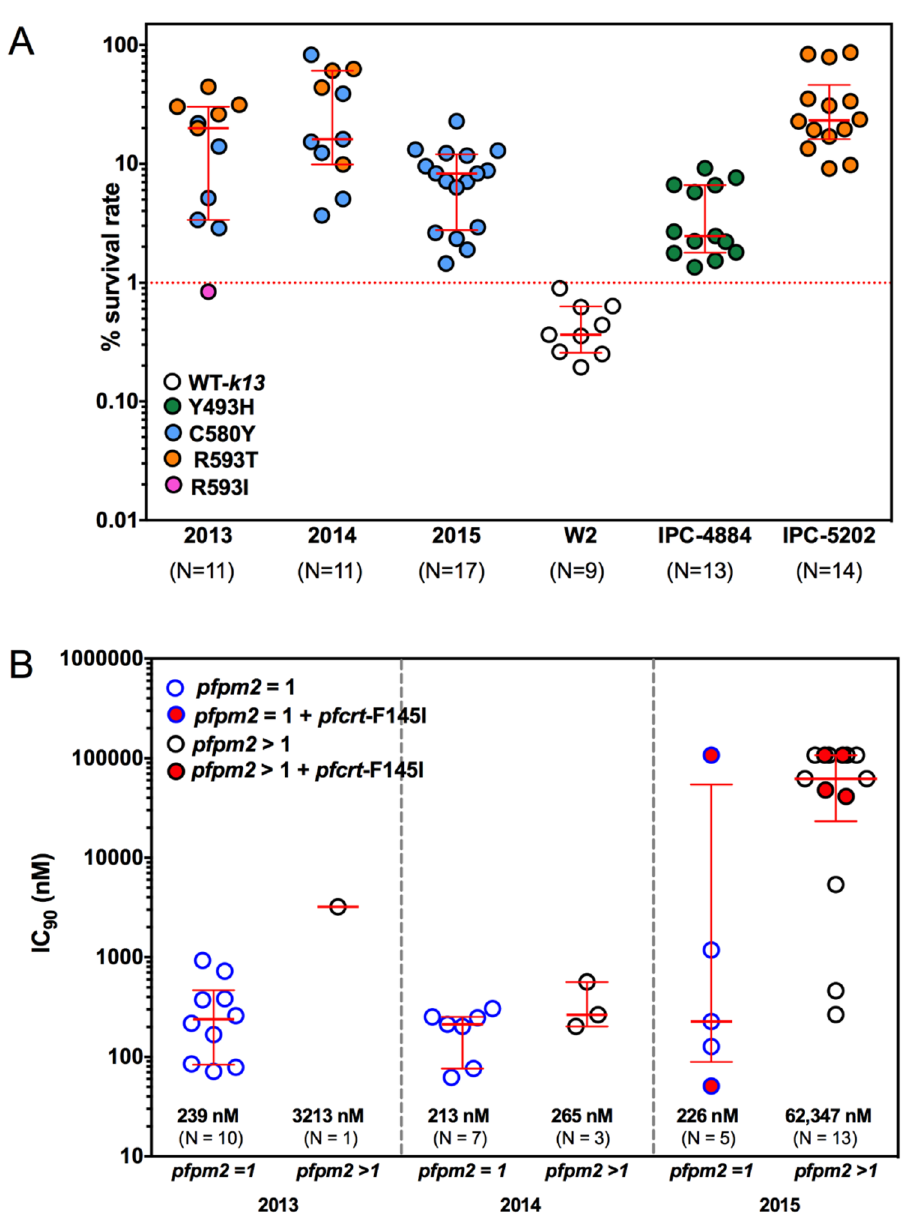
Figure 2. In vitro characterization. ( A ) RSA and pfk13 mutations. RSA 0-3 h survival rate for standard laboratory- adapted clones (W2 for ART-sensitive control, IPC-4884 and IPC-5202 for ART-resistance control) and culture-adapted clinical isolates. The dashed line represents the 1% survival rate cut-off that differentiates ART- resistance (≥ 1% red-dashed line) from ART-sensitive (< 1%) parasites in RSAs. Median and interquartile ranges are shown. ( B ) IC 90 to PIP in parasites with pfcrt -F145I mutation, with and without pfpm2 amplification. Copy number variations of pfpm2 are shown on the x-axis, and PIP-IC 90 is shown on the y-axis (log 10